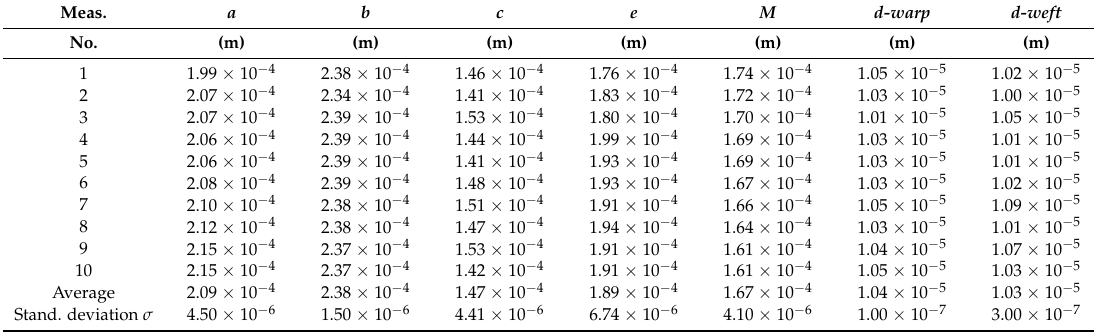
Figure 12. Measurement of input parameters for the theoretical length of the warp and weft calculation for the sample RSKCu+Ni. Table 9. The measurement results of input parameters a , b , c, e , M, d-warp , and d-weft -RSKCu+Ni.